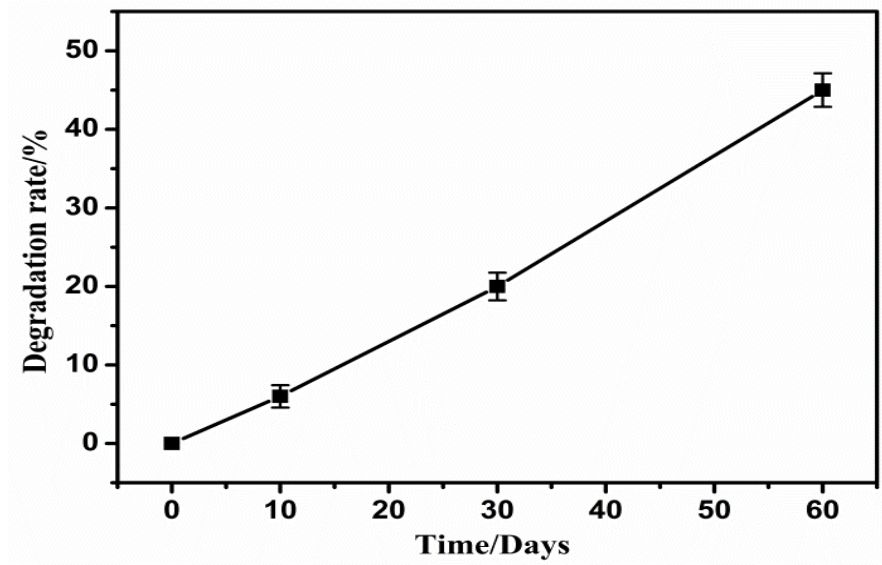
Figure 3. Degradation of the porous film in soil